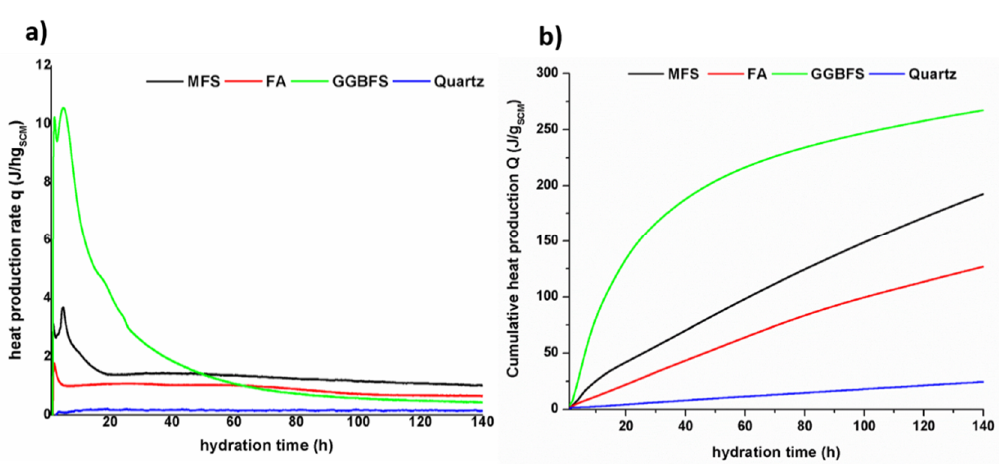
Figure 1. Calorimetric analysis of the R 3 model paste: ( a ) Heat production rate in J/(h·g scm ) vs. hydration time (h); ( b ) cumulative heat production in J/(g scm ) vs. hydration time (h).